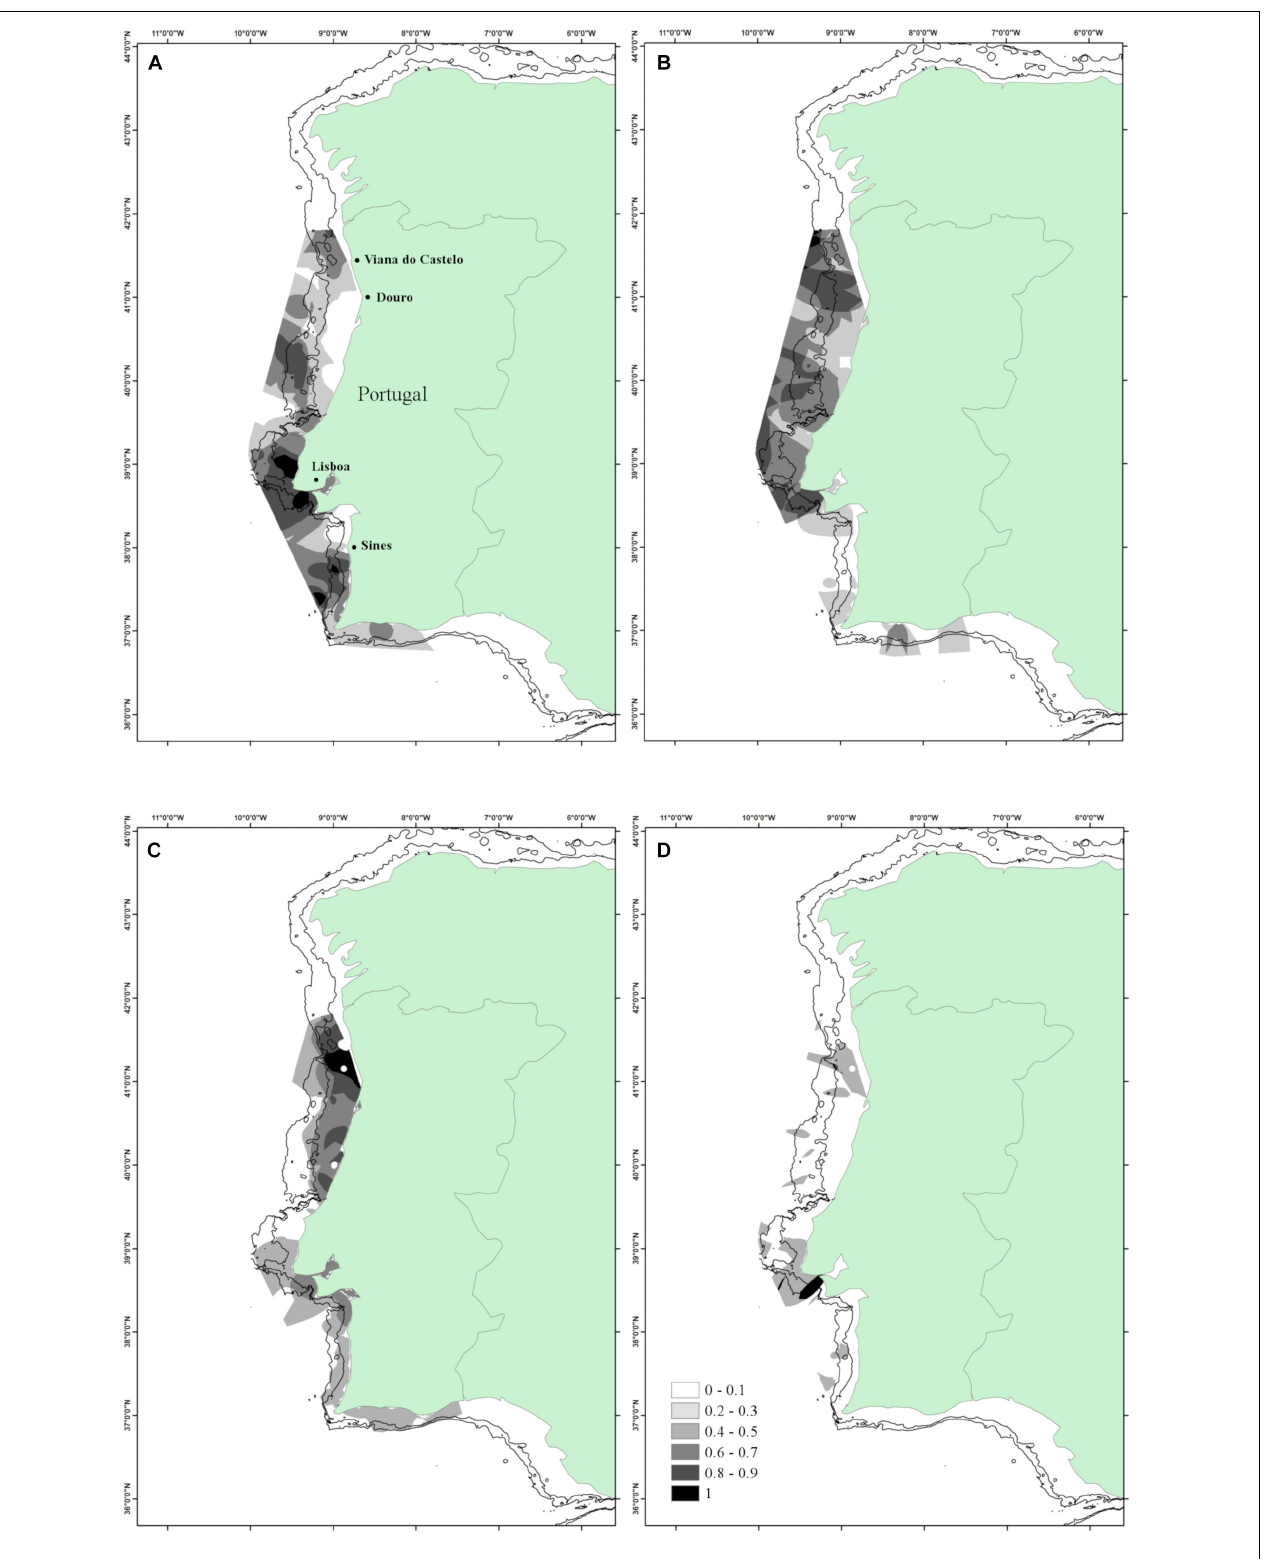
FIGURE 6 | Area 4 – Portuguese area. (A) Persistence index of M. merluccius ; (B) persistence index of Micromesistius poutassou ; (C) persistence index of T. trachurus ; (D) interspecific persistence index (IPI). Depth contours shown are 100 and 200 m.